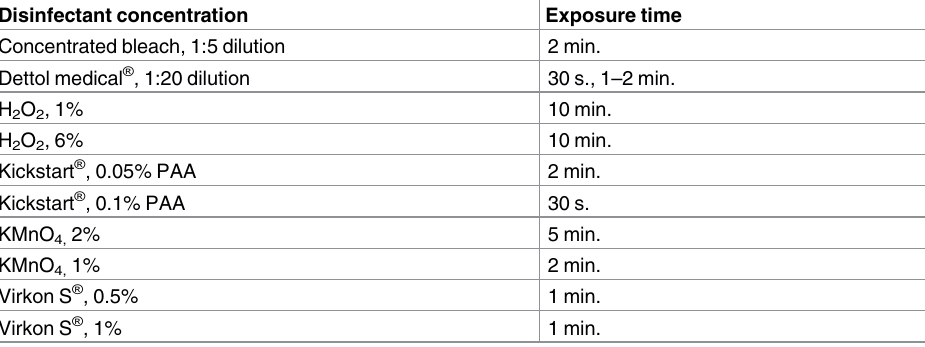
Table 1. Suboptimal disinfectant conditions for Bsal